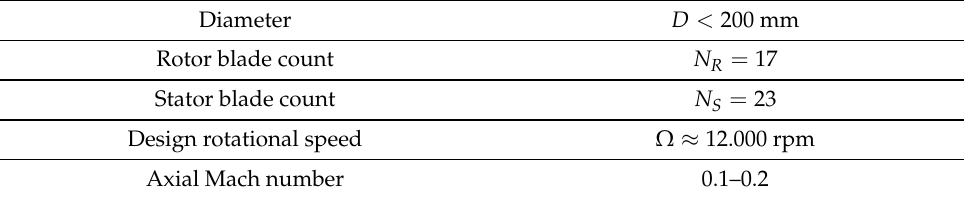
Figure 6. 3D view of the fan stage. Table 1. Fan stage characteristics, from